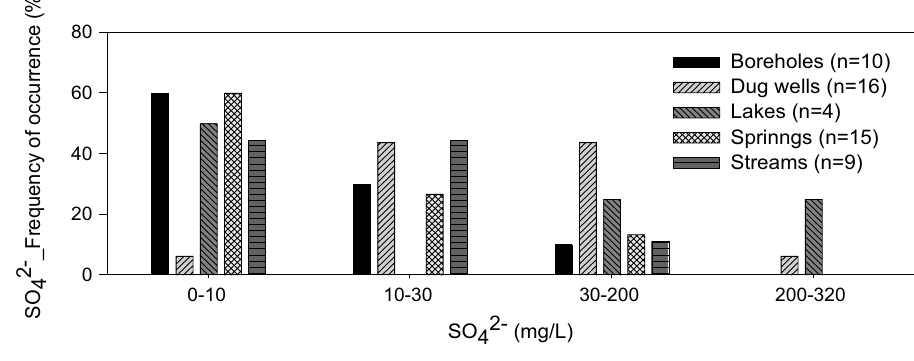
Fig. 9 Distribution of SO 42− in all water